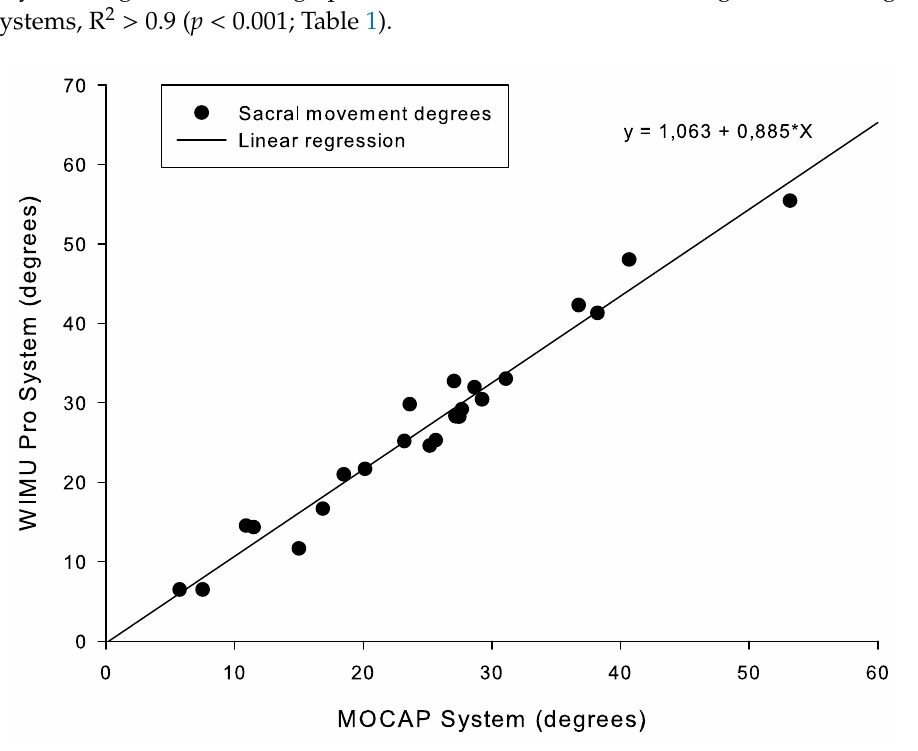
Table 2. Test–retest reliability of WIMU Pro and MOCAP system when used to monitor the range of motion during fast- and slow-paced IOCs .